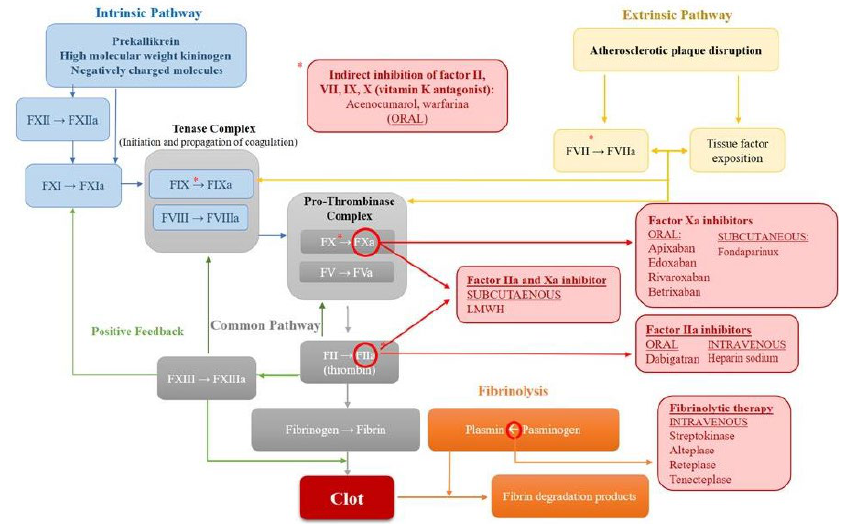
Figure 2. Diagram of the coagulation and fibrinolytic pathways and the different anticoagulants and fibrinolytic agents used in the clinical setting. LMWH: low molecular weight heparin. * Indirect inhibition of factors II, VII, IX and X.